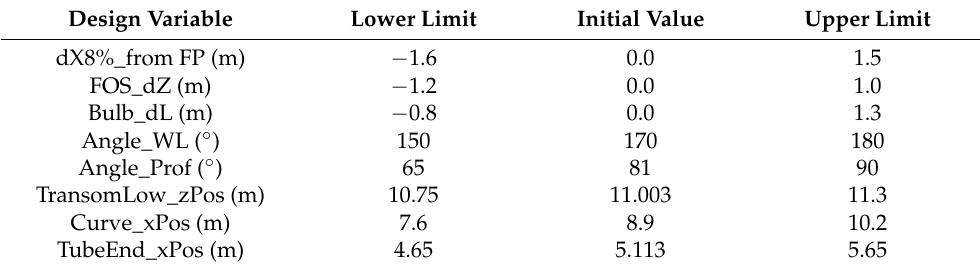
Figure 3. The control lines and the surface of the bow bulb. Table 1. The initial values and limits of variation of design variables.